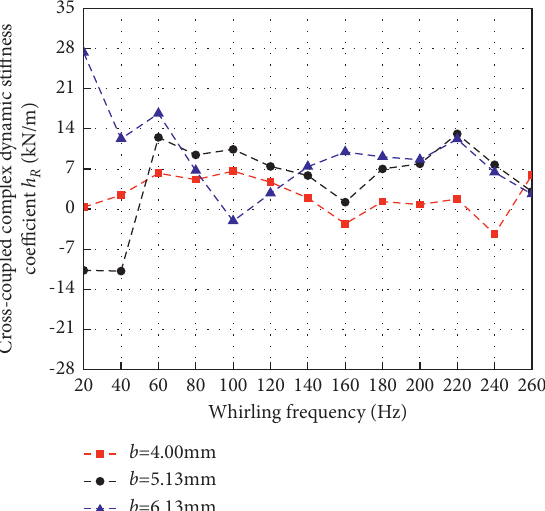
Figure 21: Cross-coupled complex dynamic stiffness coefficient vs. whirling